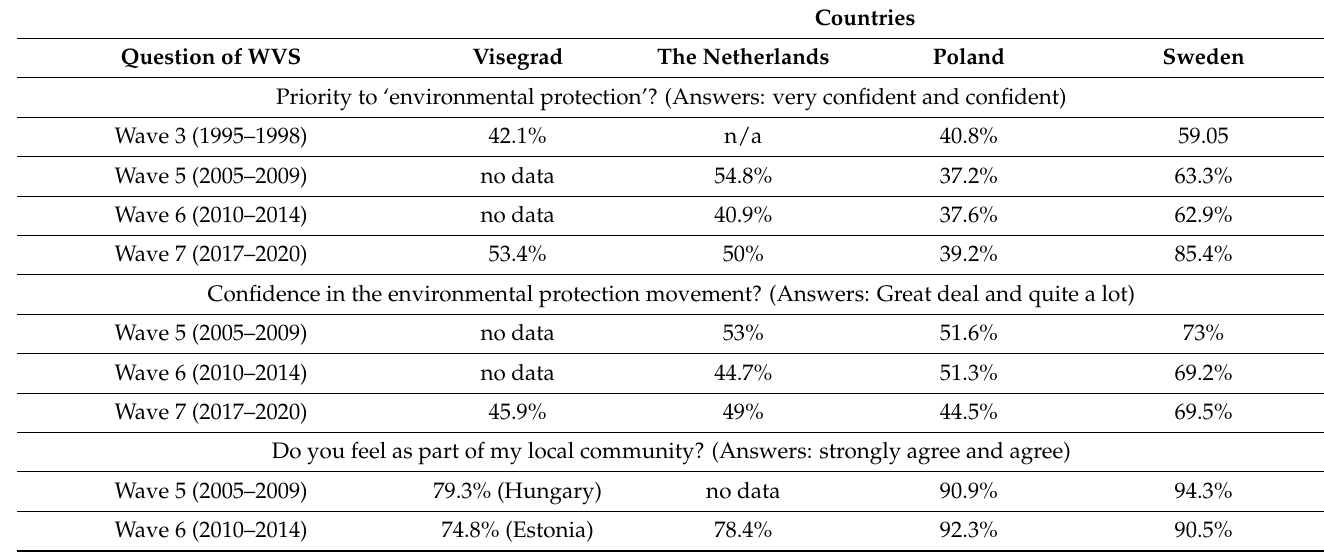
Table 2. Values towards environmental protection and local community. Data source: WVS [50].